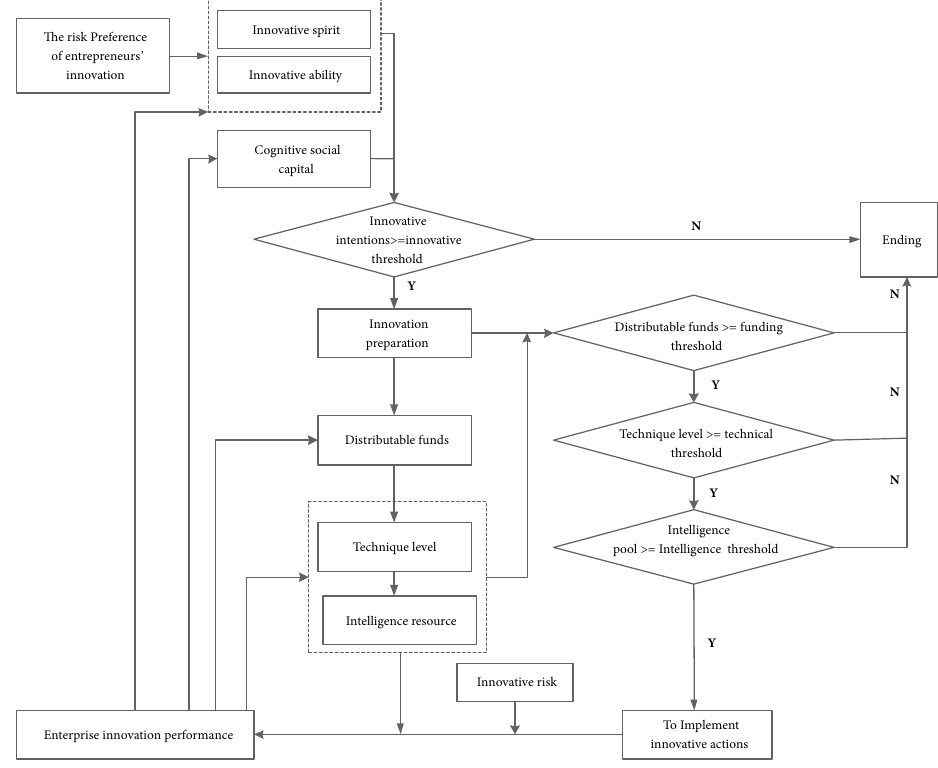
Figure 2. The workflow of innovation behavior of new generation